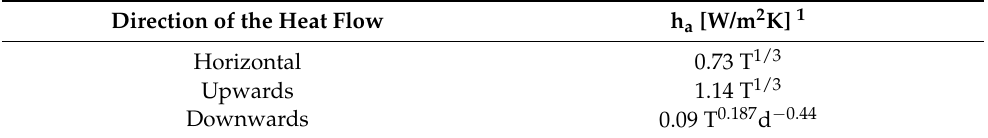
Table 3. Values for the convective heat transfer coefficient (h a ) according to the direction of the heat flow for temperature difference higher than 5 K